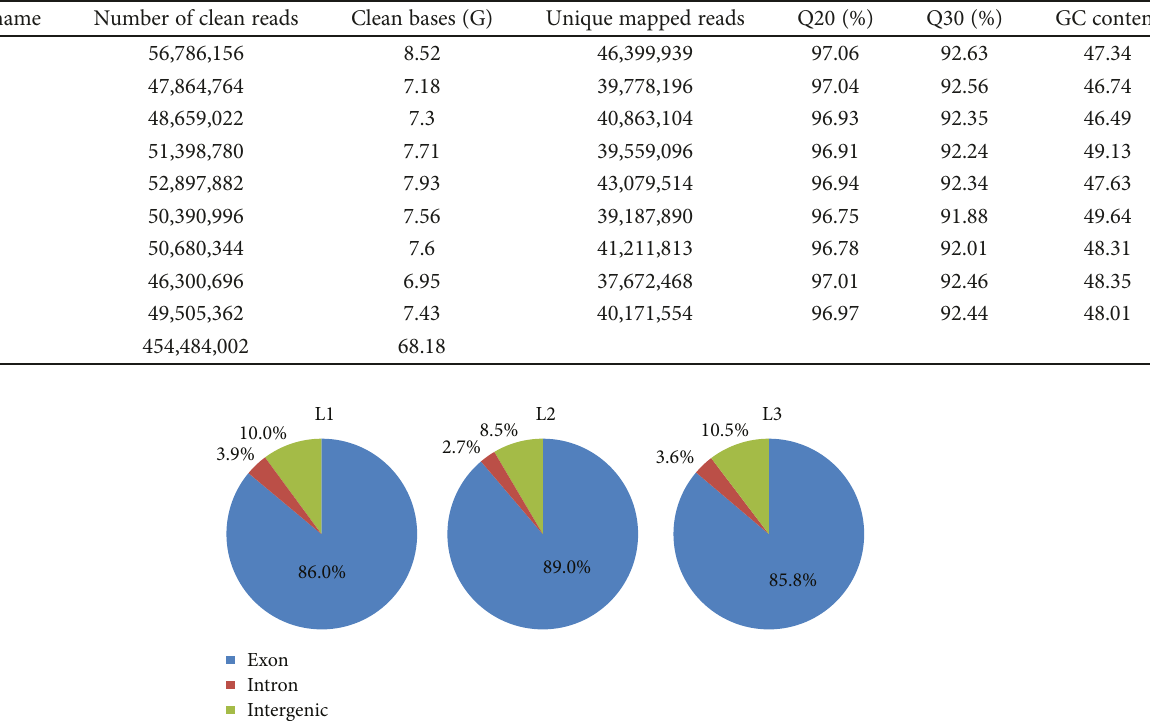
Table 3: Data statistics of transcriptome sequencing.